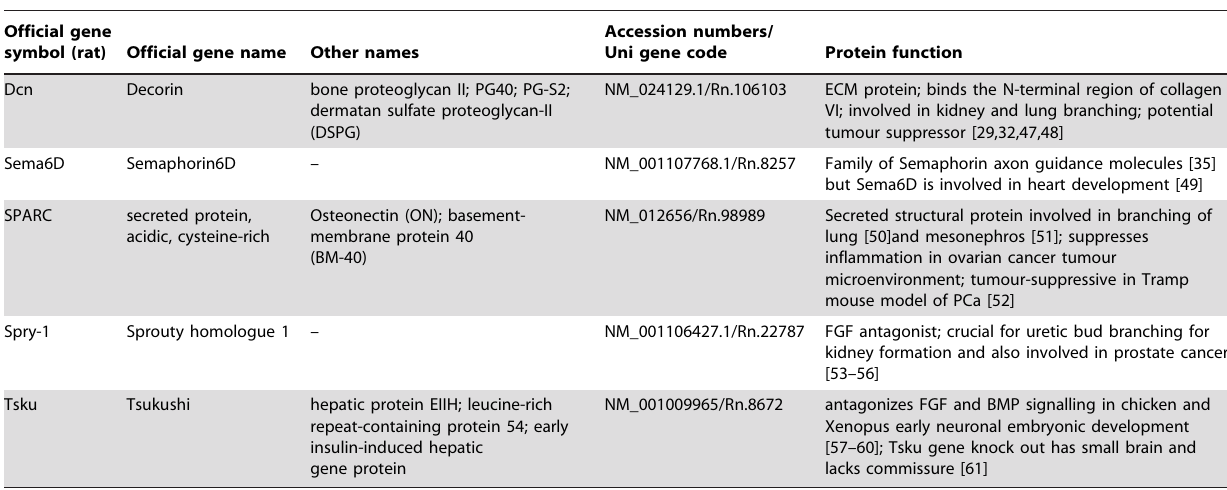
Table 1. Overview of candidate genes.